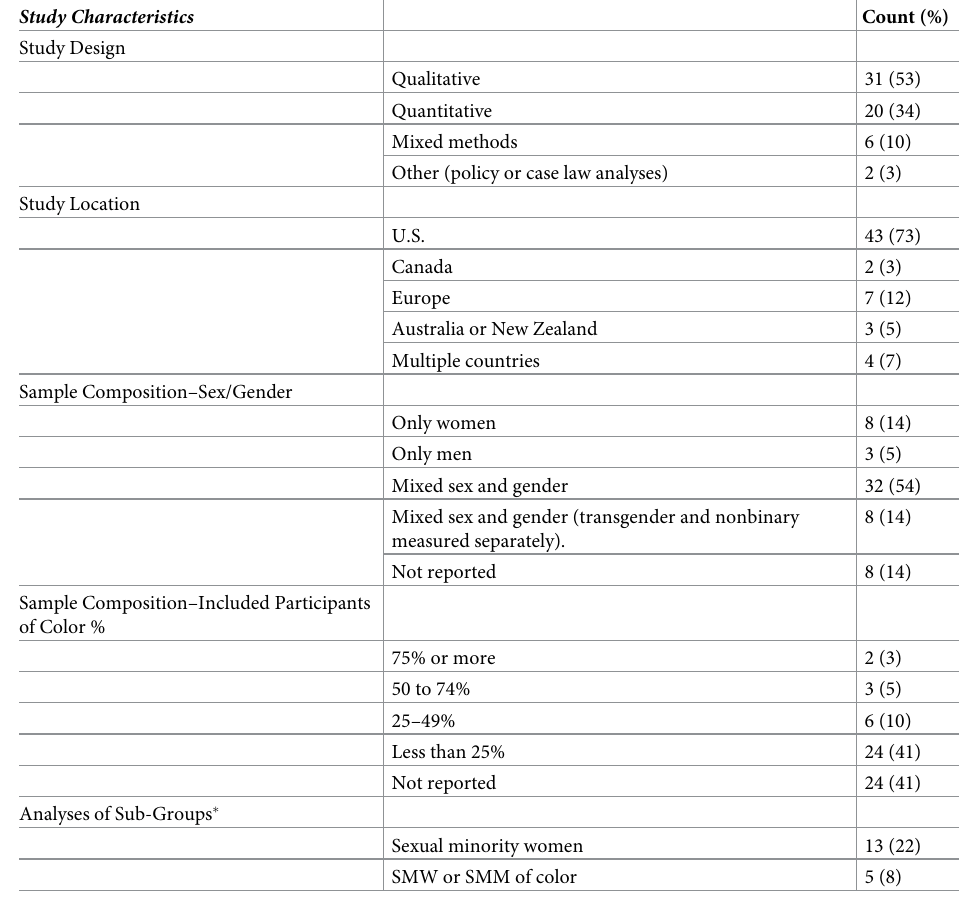
Table 2. Summary of study characteristics (N =